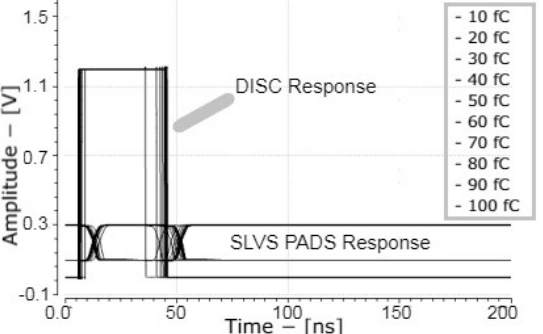
Figure 13. Comparator and SLVS drivers post-layout simulation results vs. input charges.